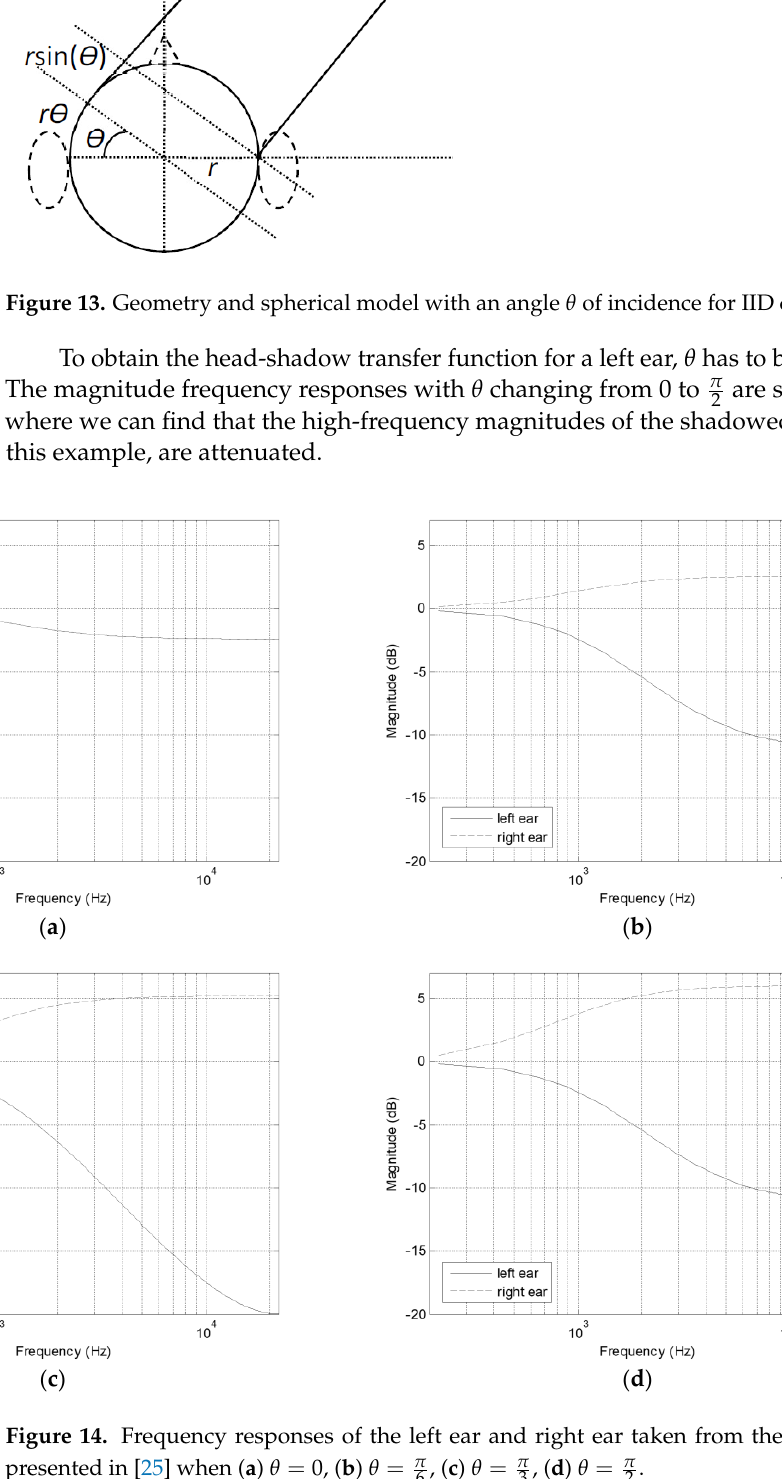
, (c) 𝛳 = 𝜋 , (d) 𝛳 = 𝜋 . 6 3 2 , ( c ) θ = π , ( d ) θ = π 6 3 2